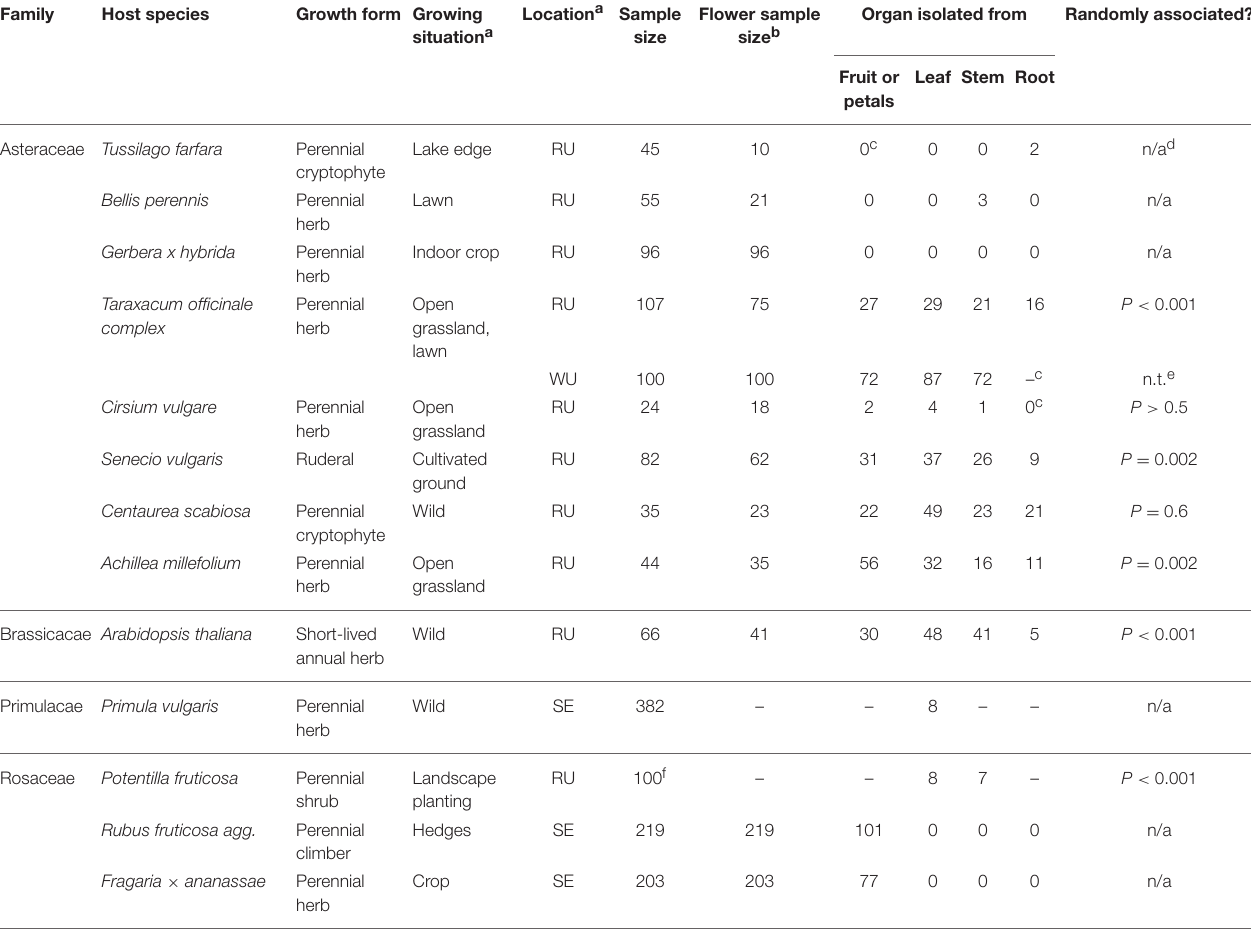
TABLE 1 | Percentage of samples showing cryptic infection with Botrytis in various host plant species.